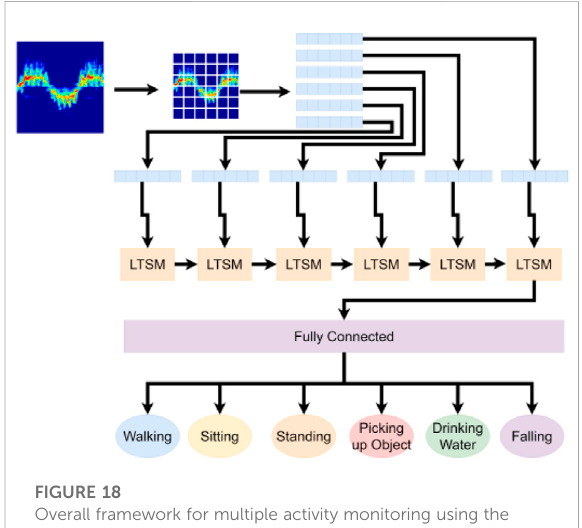
FIGURE 18 Overall framework for multiple activity monitoring using the FMCW radar (Saeed et al.,